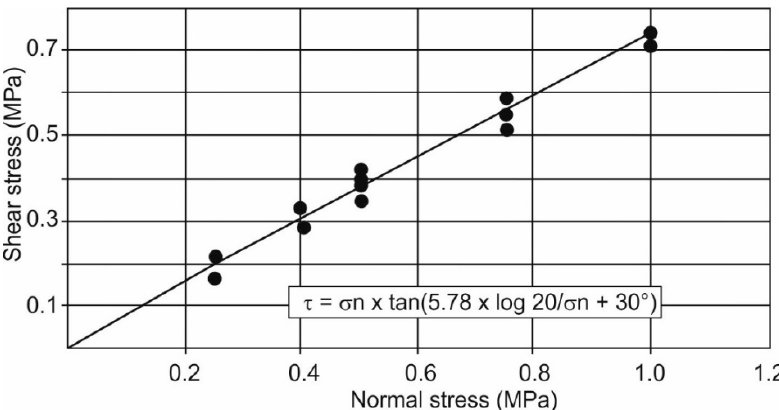
Figure 4. Peak shear strength envelope concerning data from 13 shear tests.